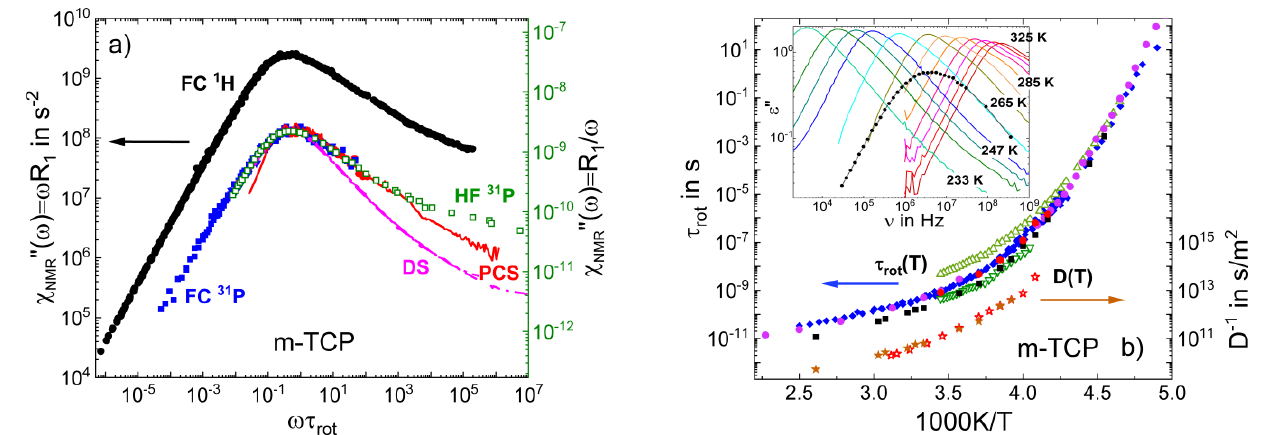
Figure 5. ( a ) NMR susceptibility master curves of m-tricresyl phosphate (m-TCP) determined from FC 1 H relaxometry (black circles; constructed from data in the range 220 K–383 K), 31 P NMR relaxometry (blue squares; data in the range 240 K–290 K), and high-field 31 P NMR (green open squares) [90]. The latter are dominated by the CSA interaction and rescaled in amplitude (right ordinate). Added are the PCS (red line) [4]) and DS (magenta line) [93,94] susceptibilities close to T g . ( b ) Rotational correlation times of m-TCP as obtained from different techniques: DS—open green triangles [53]; high-field 31 P NMR relaxation—blue squares [90]; FC 31 P NMR—red circles [53]; FC 1 H NMR—black squares [53]; and DLS—violet circles [92]. Reciprocal diffusion coefficient D − 1 (T) measured by FC relaxometry (open orange stars) [53] and by static field gradient (SFG) diffusometry (solid brown stars) [53]—right ordinate. Inset: dielectric spectra of m-TCP at high temperatures revealing a bimodal spectral shape; included is a FC 1 H NMR spectrum at the corresponding temperature.